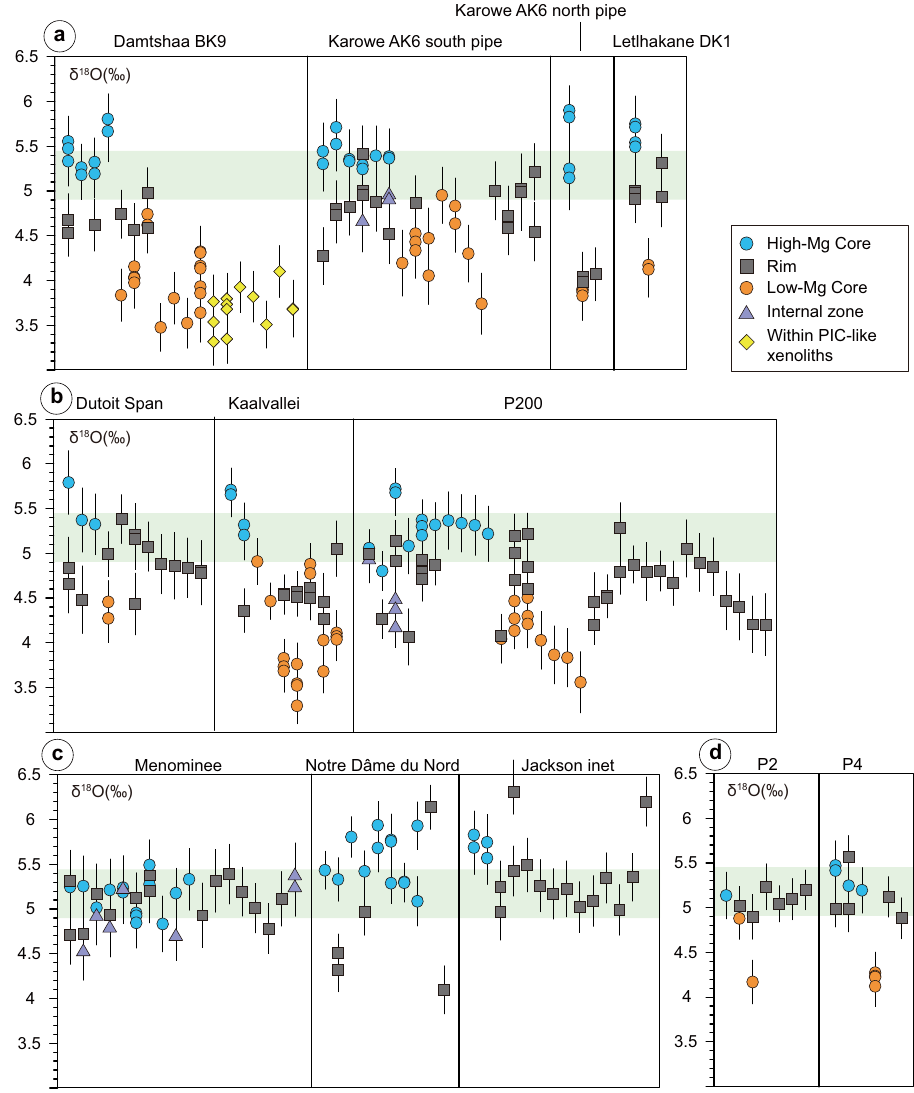
Fig. 3 Oxygen isotope composition of olivine analyzed by SIMS in this study. Olivine in kimberlites from a Botswana, b South Africa and Lesotho, c North America, and d lamproites from India. Different olivine zones from the same grain are plotted on the same x coordinates. Green bands represent the mantle olivine value (5.18 ± 0.28 ‰ ; see ref. 3 ). Error bars indicate the 2 σ of each